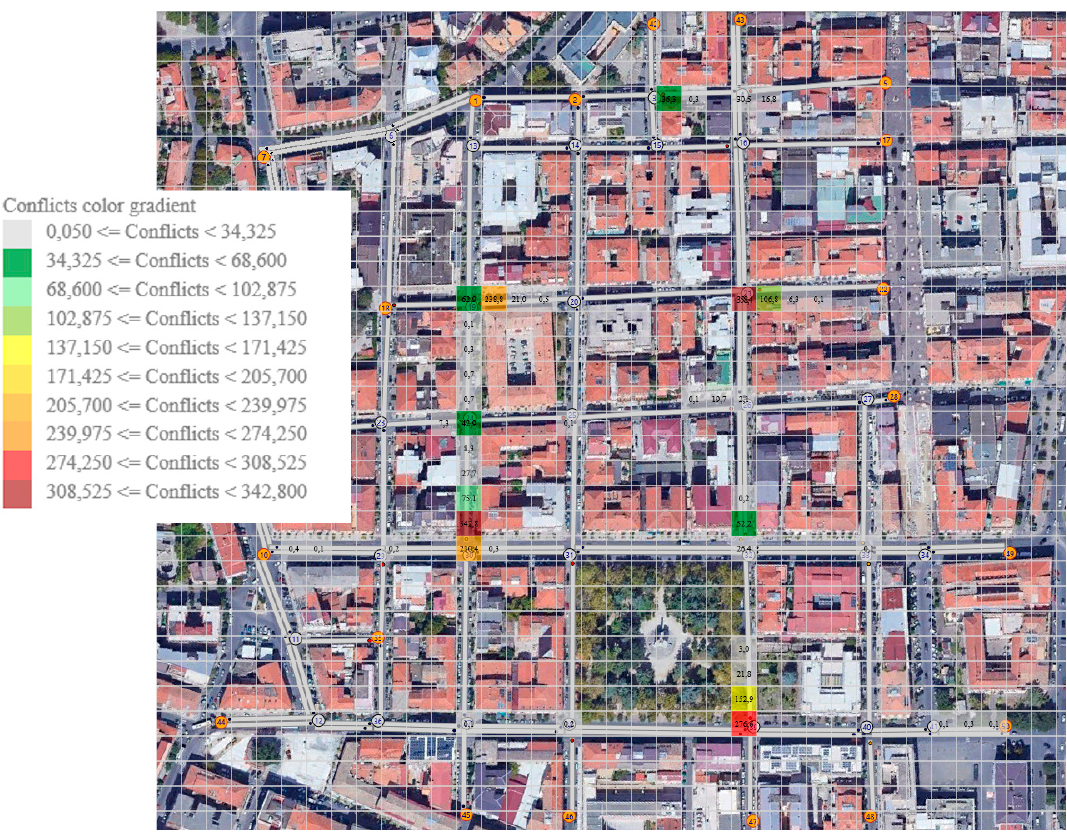
Figure 5. Potential conflicts heat-map.